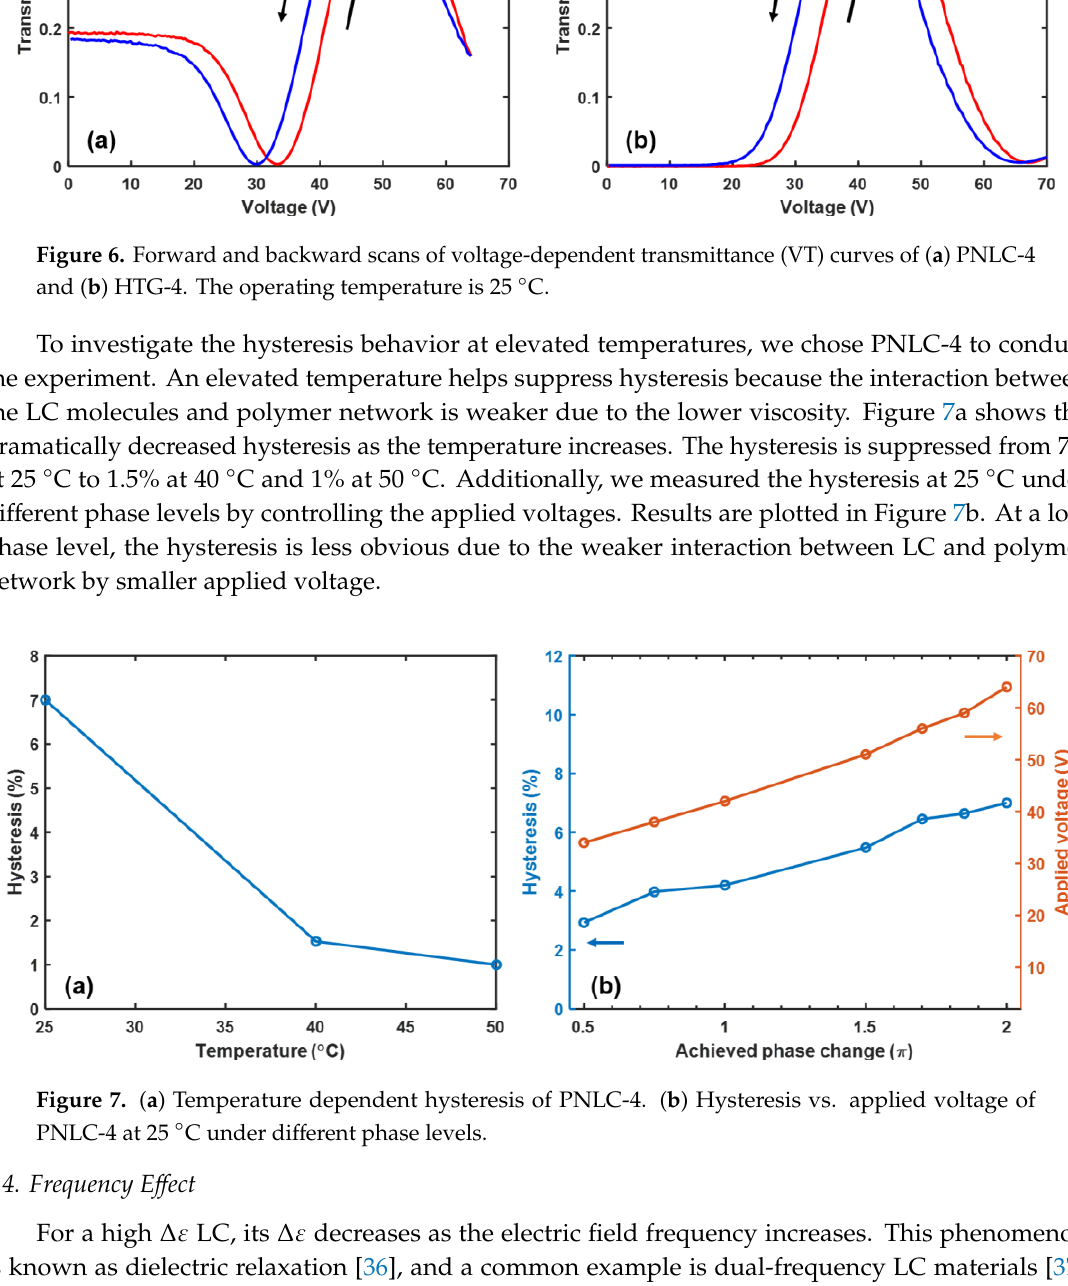
PNLC-4 at 25 °C under different phase levels. PNLC-4 at 25 ◦ C under di ff erent phase